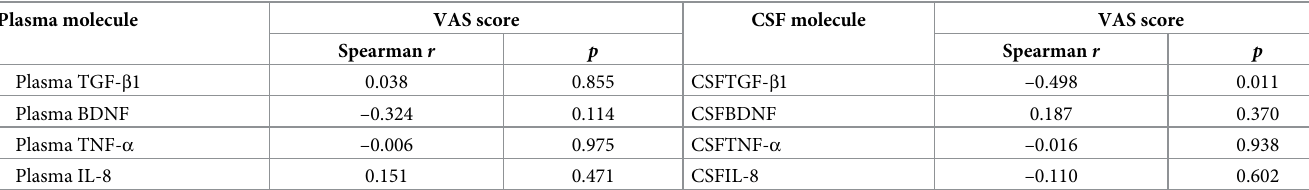
The correlation of plasma and cerebral spinal fluid (CSF) molecules with Visual Analogue Scale (VAS) scores in patients with chronic osteoarthritis (OA, n = 29). BDNF, brain derived neurotrophic factor. The Spearman correlation analysis with control of age, gender, body mass index and pain drug were used. p < 0.05 represented a significant correlation of variables with the VAS